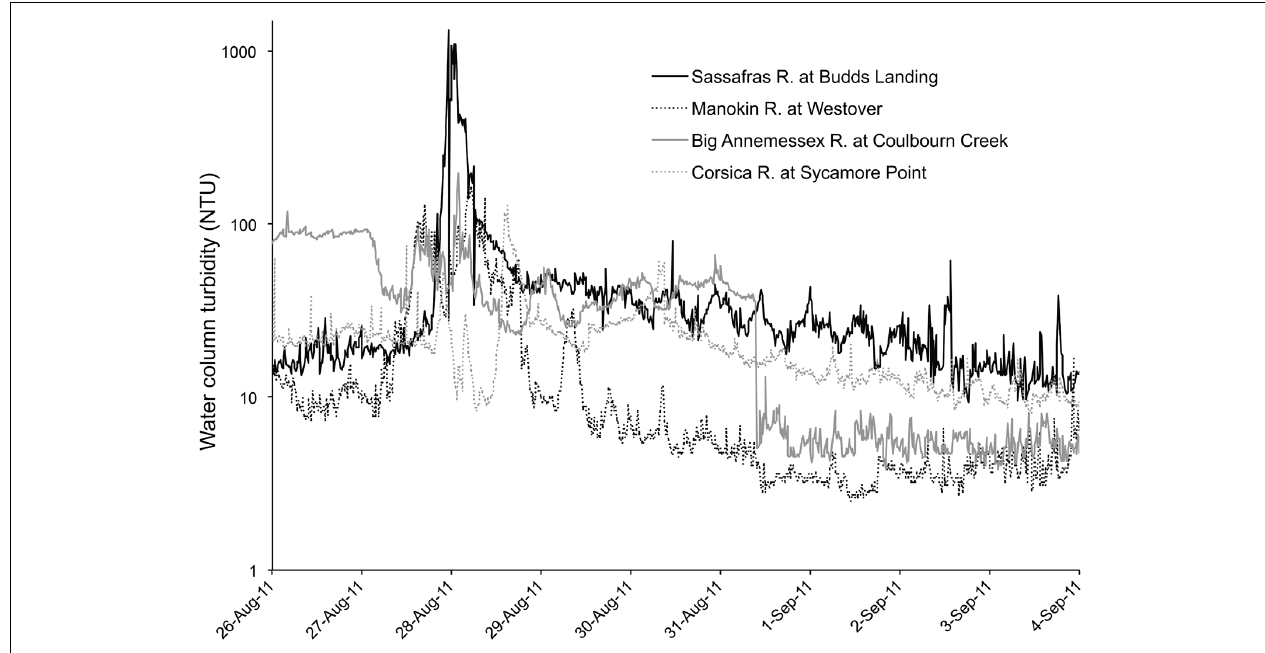
FIGURE 3 |Turbidity in Chesapeake Bay during Hurricane